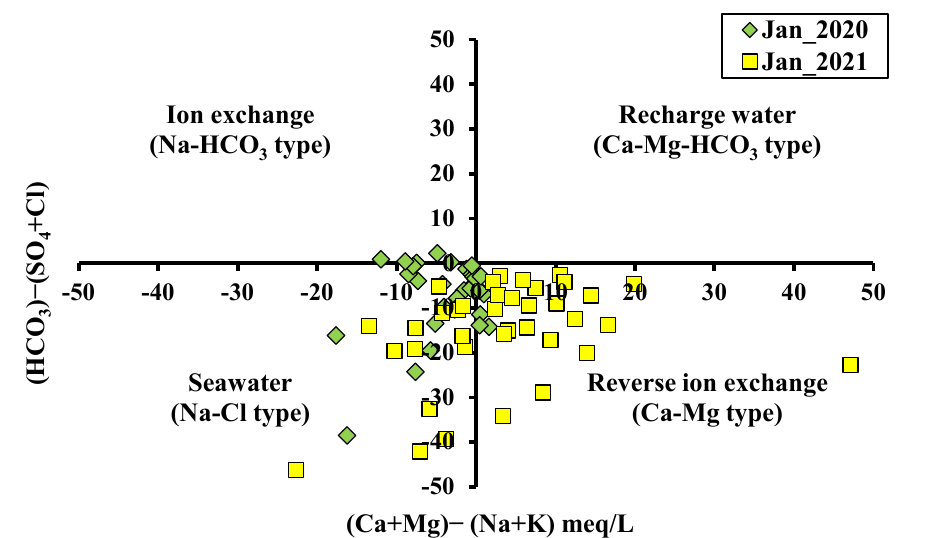
Figure 10. Chadha’s plot for the hydrogeochemical process classification.